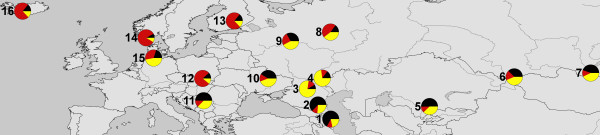
Distribution of three inferred genetic clusters in the study regions. Slices in the pie diagrams represent Fat-tailed (yellow), Composite (black) and Nordic (red) clusters. The Caucasus area is represented by four regions: South Caucasus (1), North Caucasus (2), Stavropol (3) and the Caspian depression (4). The Asian region is represented by three regions: Kazakhstan and east of the Caspian Sea region (5), the Altai region (6) and the Buryatia region (7). The remaining groups belong to eastern fringe of Europe: the Volga region (8), West Russia (9), Ukraine (10), Southeast Europe (11) Poland (12), Finland (13), Scandinavia (14), Denmark (15) and Iceland and the Faeroe Islands (16).